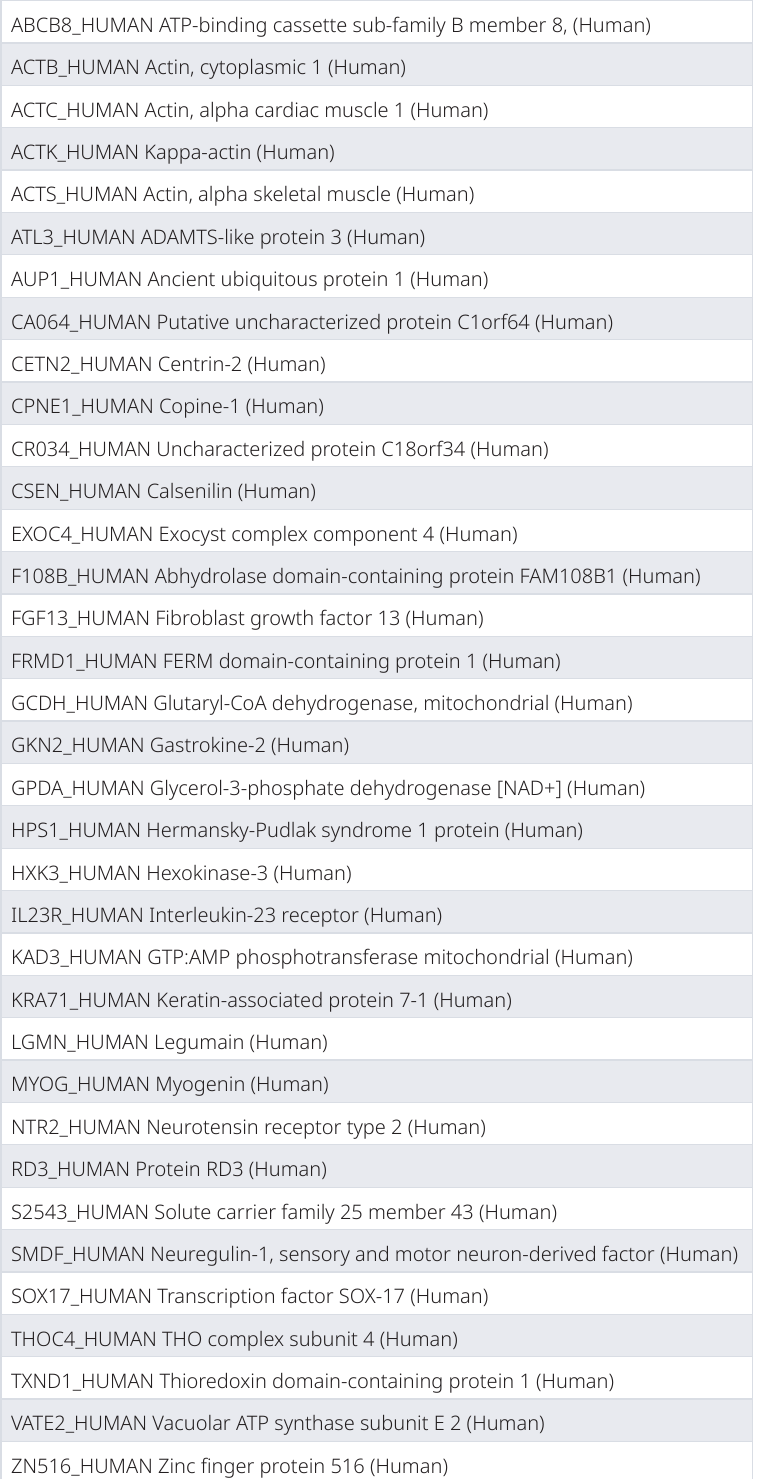
Table 3. Human proteins (uniprot.org) with the dominant peak on the frequency F(0.478) in the informational